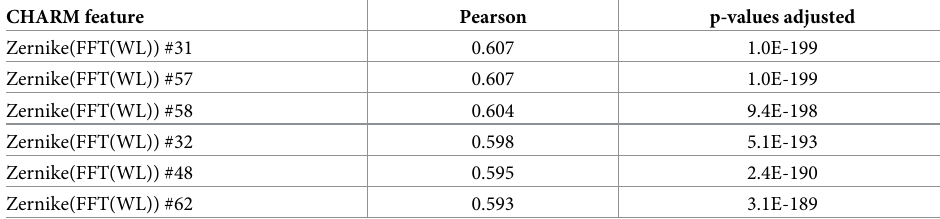
The six most correlated features shown (see text). Gender: males and females combined. For these entries, Fast Fourier transform (FFT) and wavelets (WL) [25] were used to transform each image before computing Zernike polynomials.